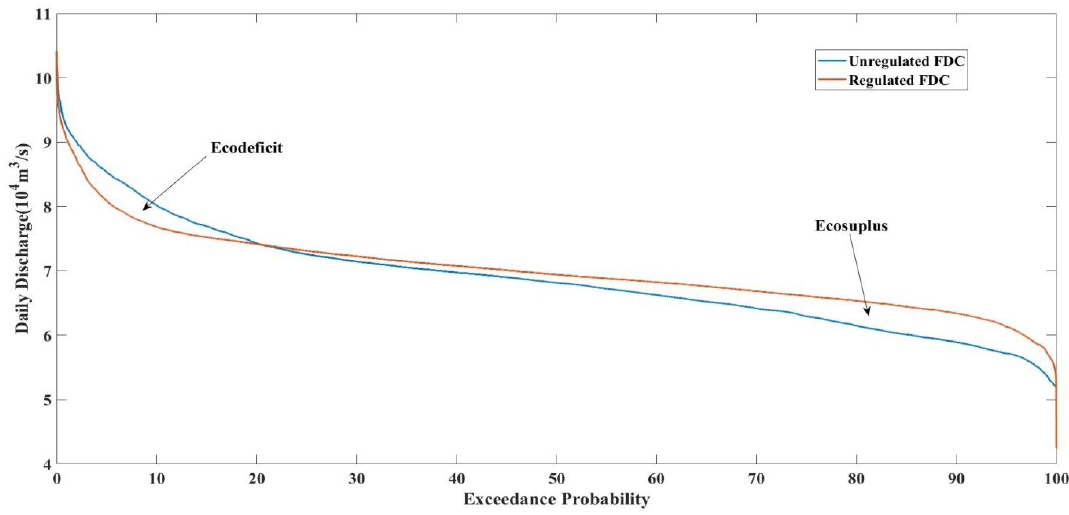
Figure 2. Definition of the ecodeficit and ecosurplus corresponding to the flow duration curves.